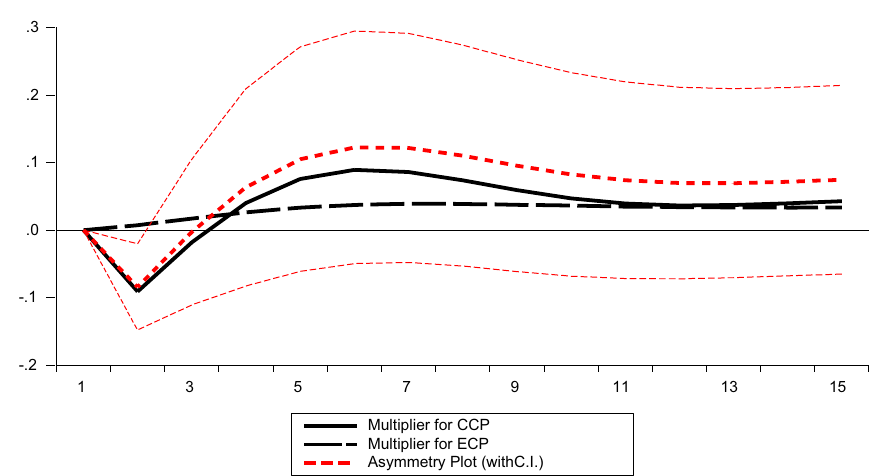
Fig. 7 Multiplier effects of commercial policies on